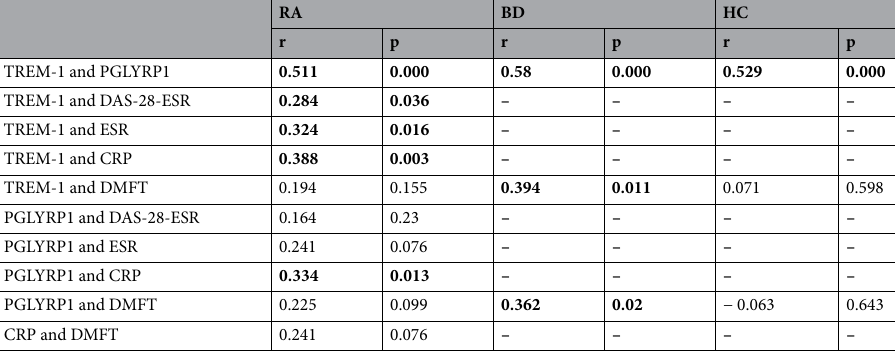
Table 3. Spearman’s correlation analyses between serum levels of TREM-1, PGLYRP1 and disease-associated factors. Significant correlations are bolded. RA rheumatoid arthritis, BD Behçet’s disease, HC healthy control, DAS-28-ESR 28-joints disease activity score based on erythrocyte sedimentation rate, DMFT decayed, missing and filled teeth index, ESR erythrocyte sedimentation rate, CRP C-reactive